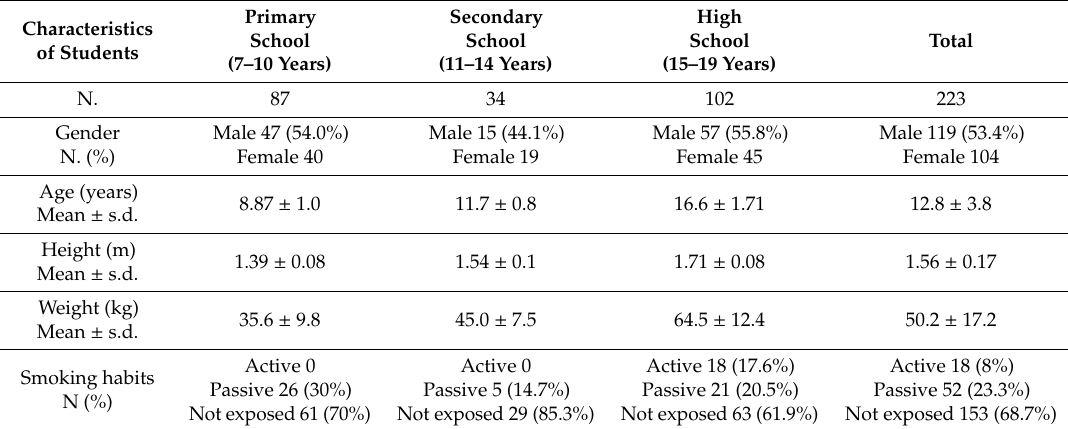
Table 1. Gender, age, height, weight, and number of active and passive smokers in the whole population and in three groups subgrouped according to the three educational level considered.